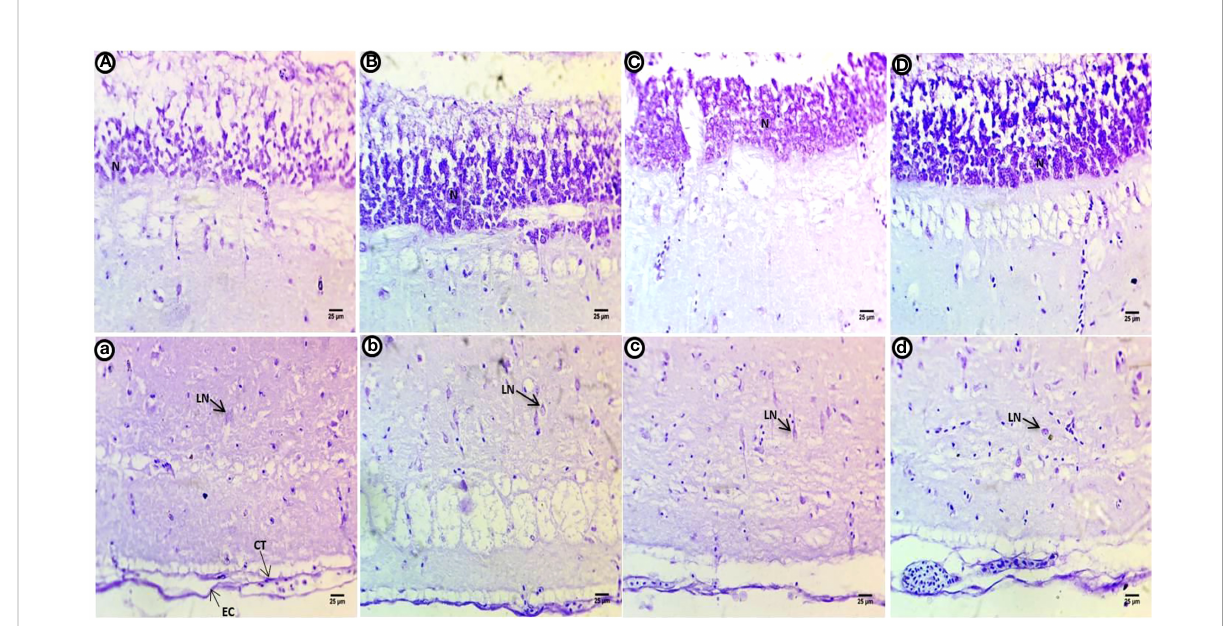
FIGURE 5 Crystal violet-stained sections of the optic tectum of common carp after the two-week post exposure period showing control group (A, a) , 10 mg/L PE-MP group (B, b) , 10 mg/L PE-MPs + 200 µg/L 4-NPgroup (C, c) , and 200 µg/L 4-NP group (D, d) . Large neurons (LN), connective tissue (CT), epithelial cells (EC).